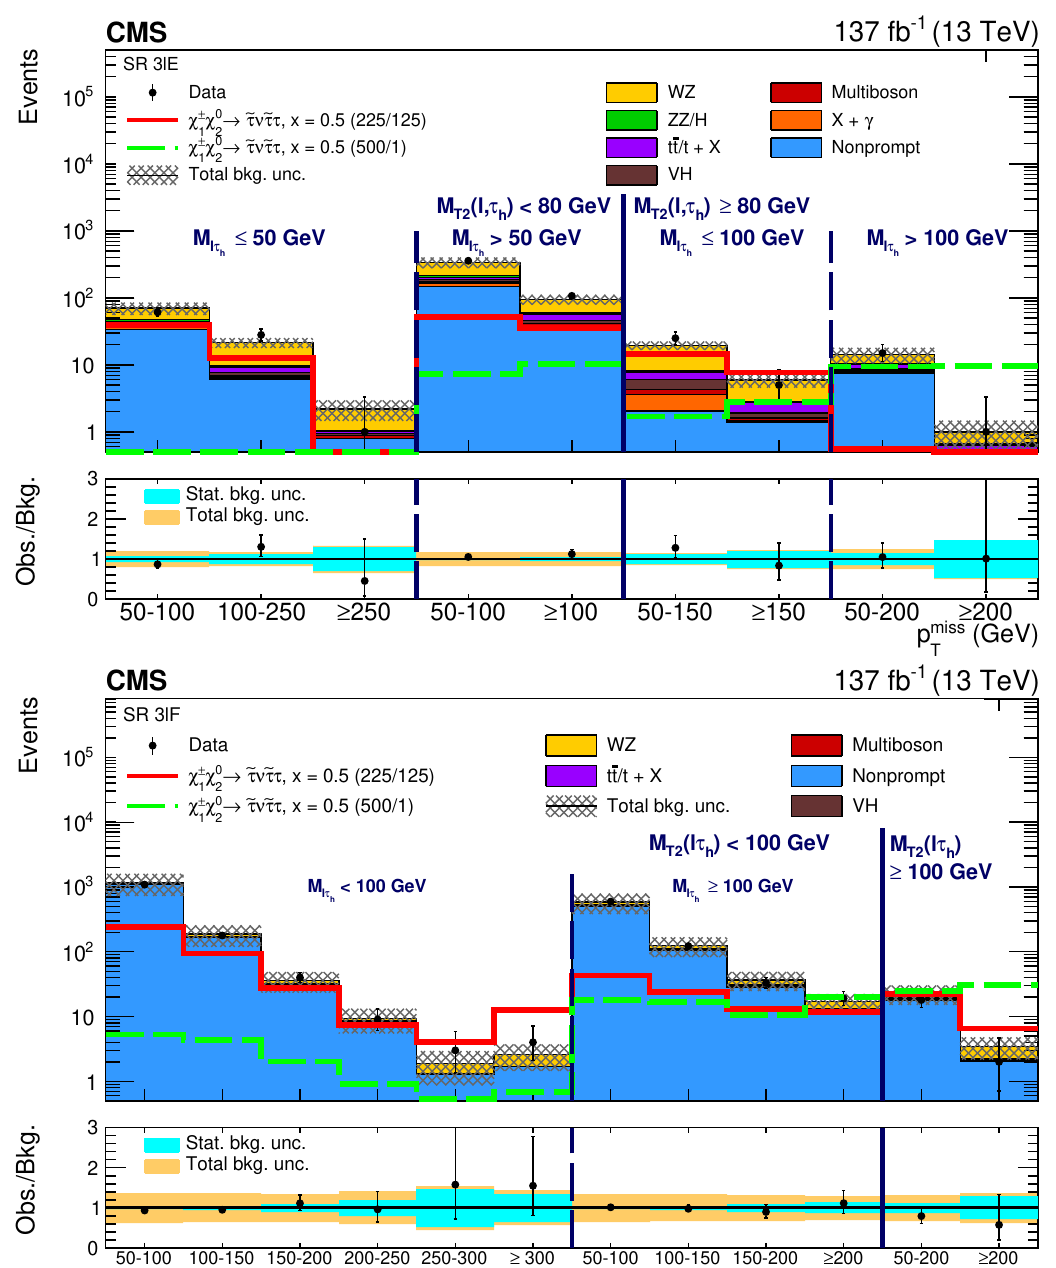
Figure 12 . Observed and expected yields across the search regions in events (upper plot) with a same-sign light lepton pair and a t one light lepton (3 ‘ F). Several signal models are shown superimposed. They correspond to production with slepton-mediated decays in the τ lepton dominated hypothesis for a compressed δm = 100 GeV (red line) and uncompressed δm = 500 GeV (green dashed line) scenario. The legends specify the masses of